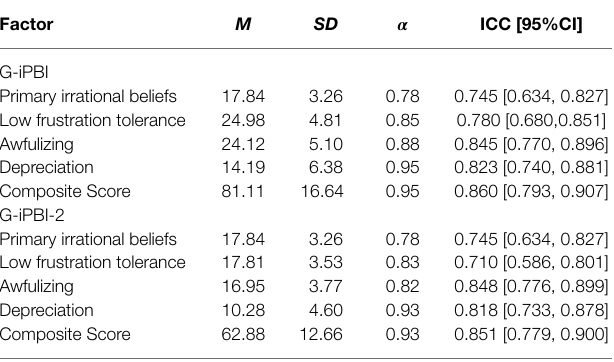
TABLE 3 | Means (M), standard deviations (SD), Cronbach’s alphas ( α ) and intra-class correlation coefficients (ICC) with their confidence interval (95% CI) for the respective subscales and the composite negative thoughts